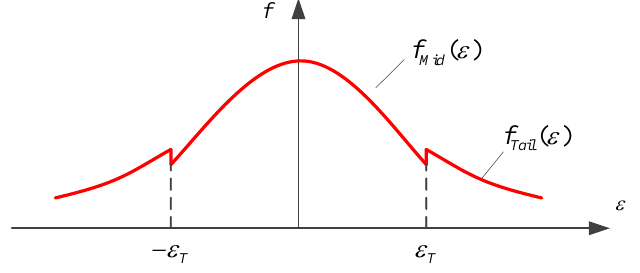
Figure 7. Diagram of bi - normal